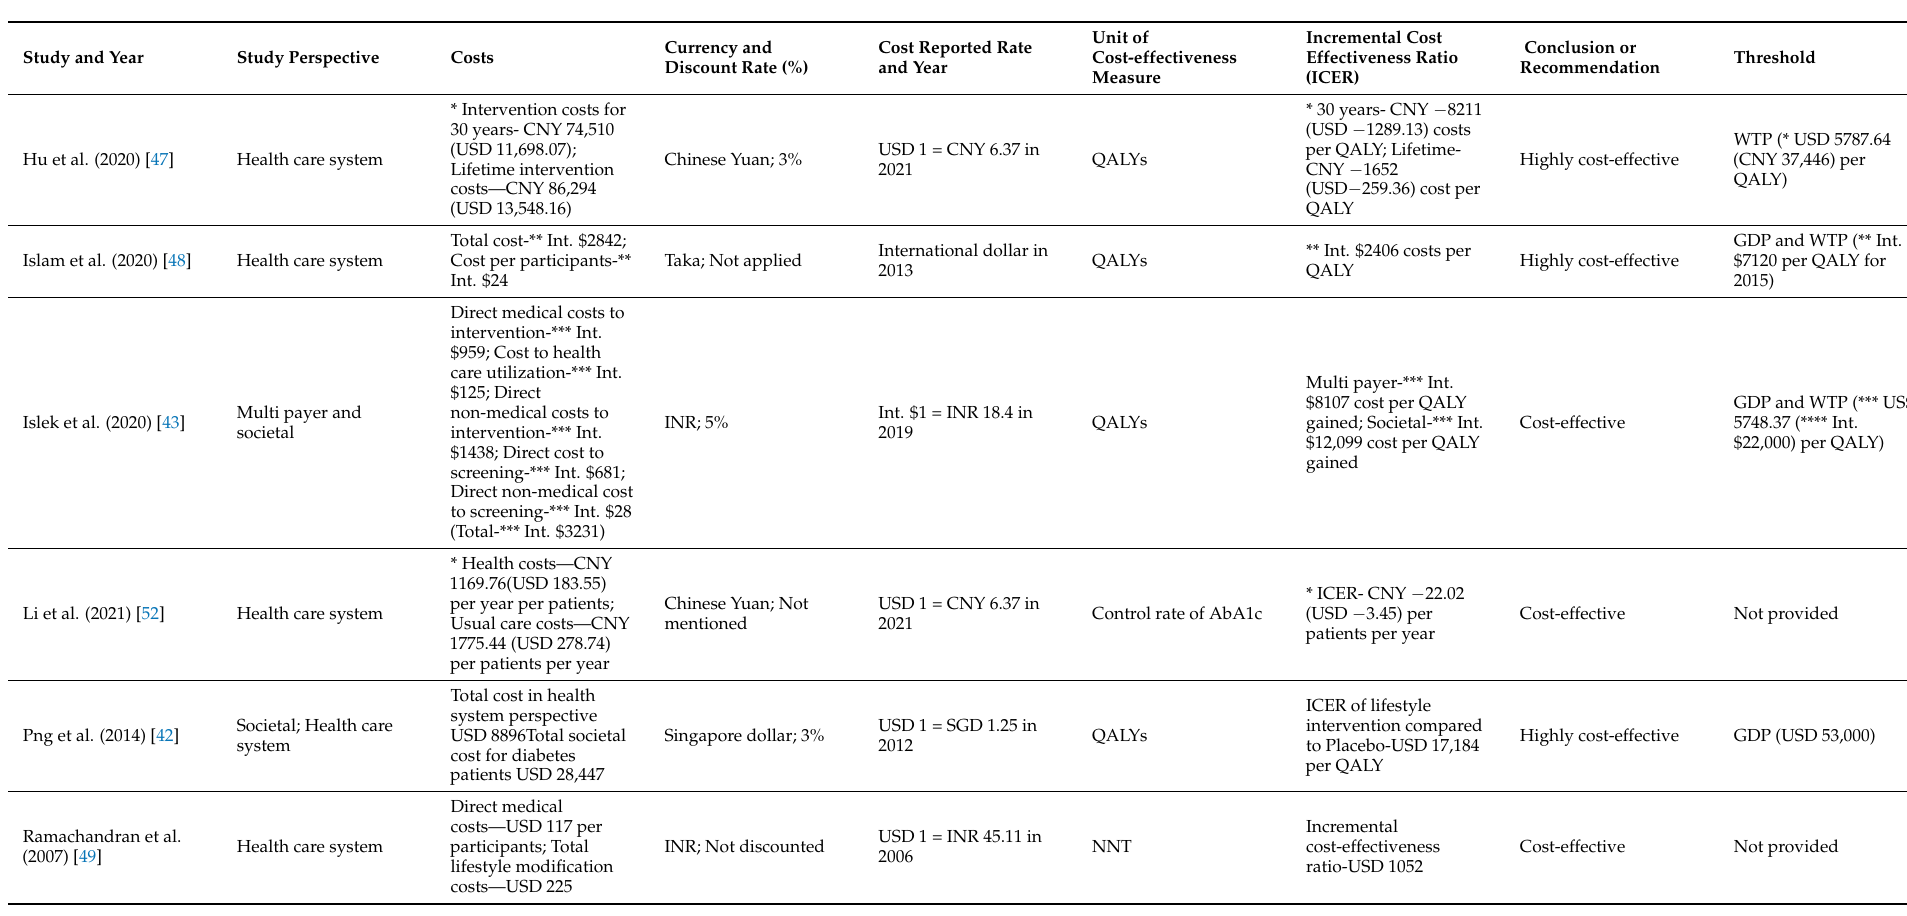
Table 4. Economic evaluation details of the health behavior